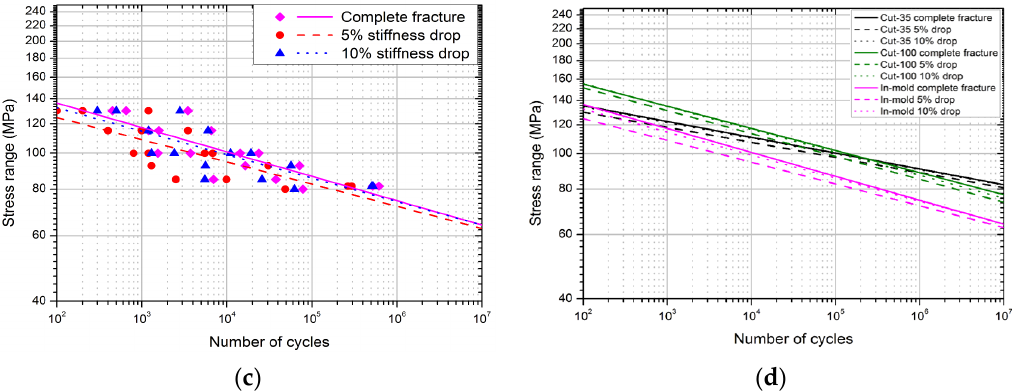
Figure 15. S–N curves of C-SMC in terms of the stiffness drop: ( a ) C-SMC-Cut-35, ( b ) C-SMC-Cut-100, ( c ) C-SMC-In-mold, and ( d ) comparison of the S–N curves on average.